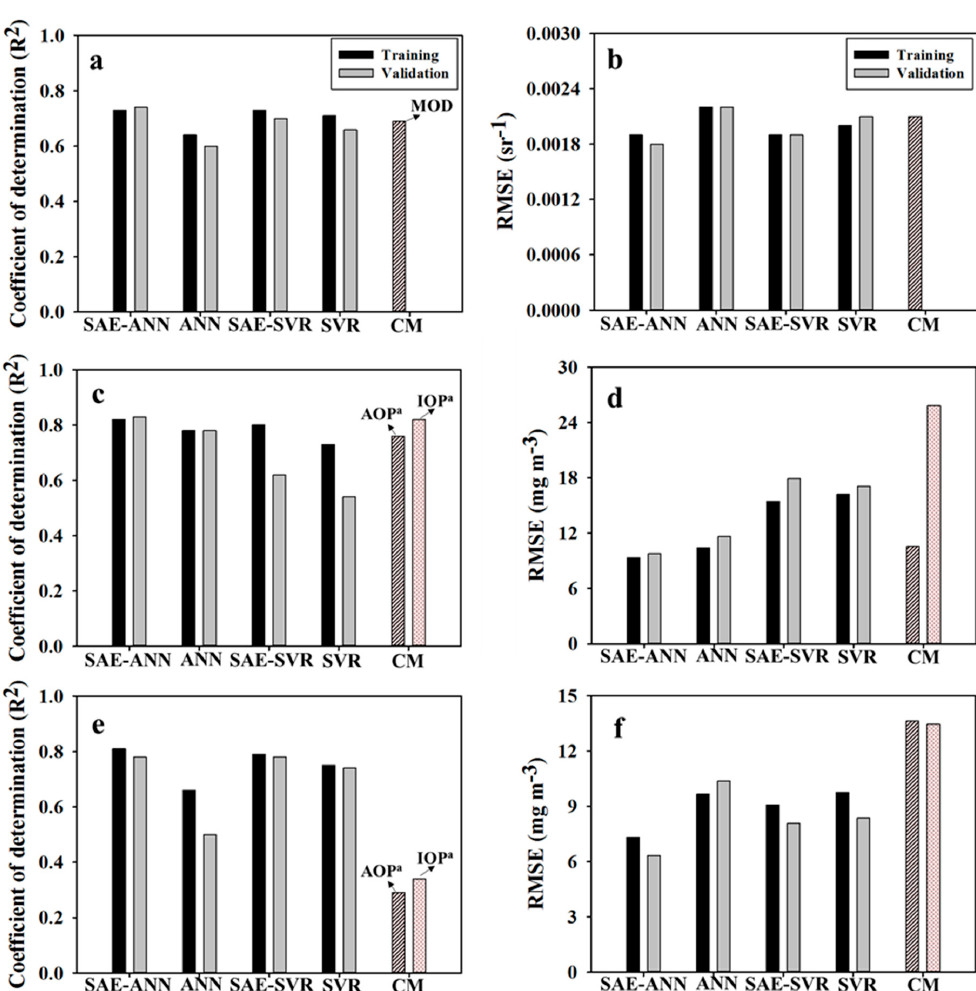
Figure 9. Accuracy of the data-driven model and the conventional model (CM): ( a–b ) AC, ( c–d ) PC estimation, and ( e–f ) Chl-a estimation. Black and gray bars represent training and validation accuracy of the data-driven models (MOD indicates water surface reflectance simulated by MODTRAN 6, AOP